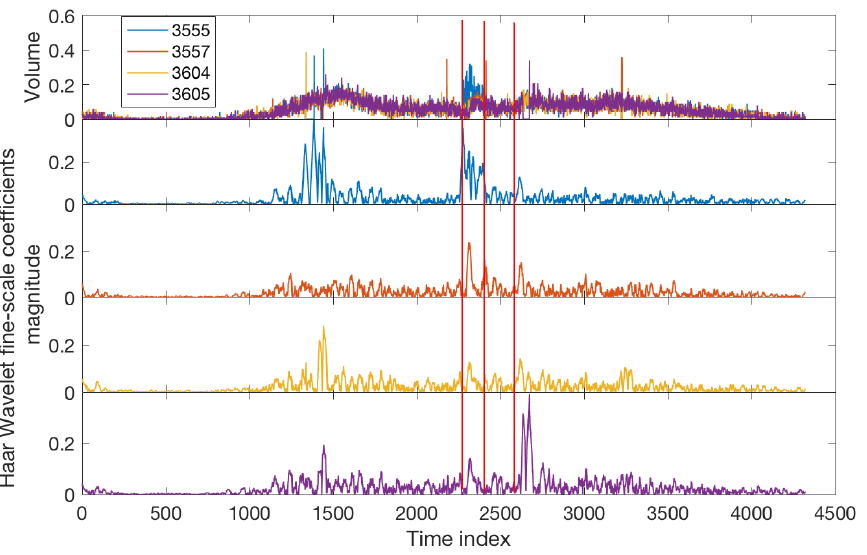
Figure 8. Incident S1: Analysis of Haar Wavelet Transform. Top panel is the volume data from four different sensors. The lower panels are the analysis results from sensors 3555, 3557, 3604, and 3605 respectively. The vertical red lines refer to the incident start time, incident end time, and queue end time respectively (see Table 1).